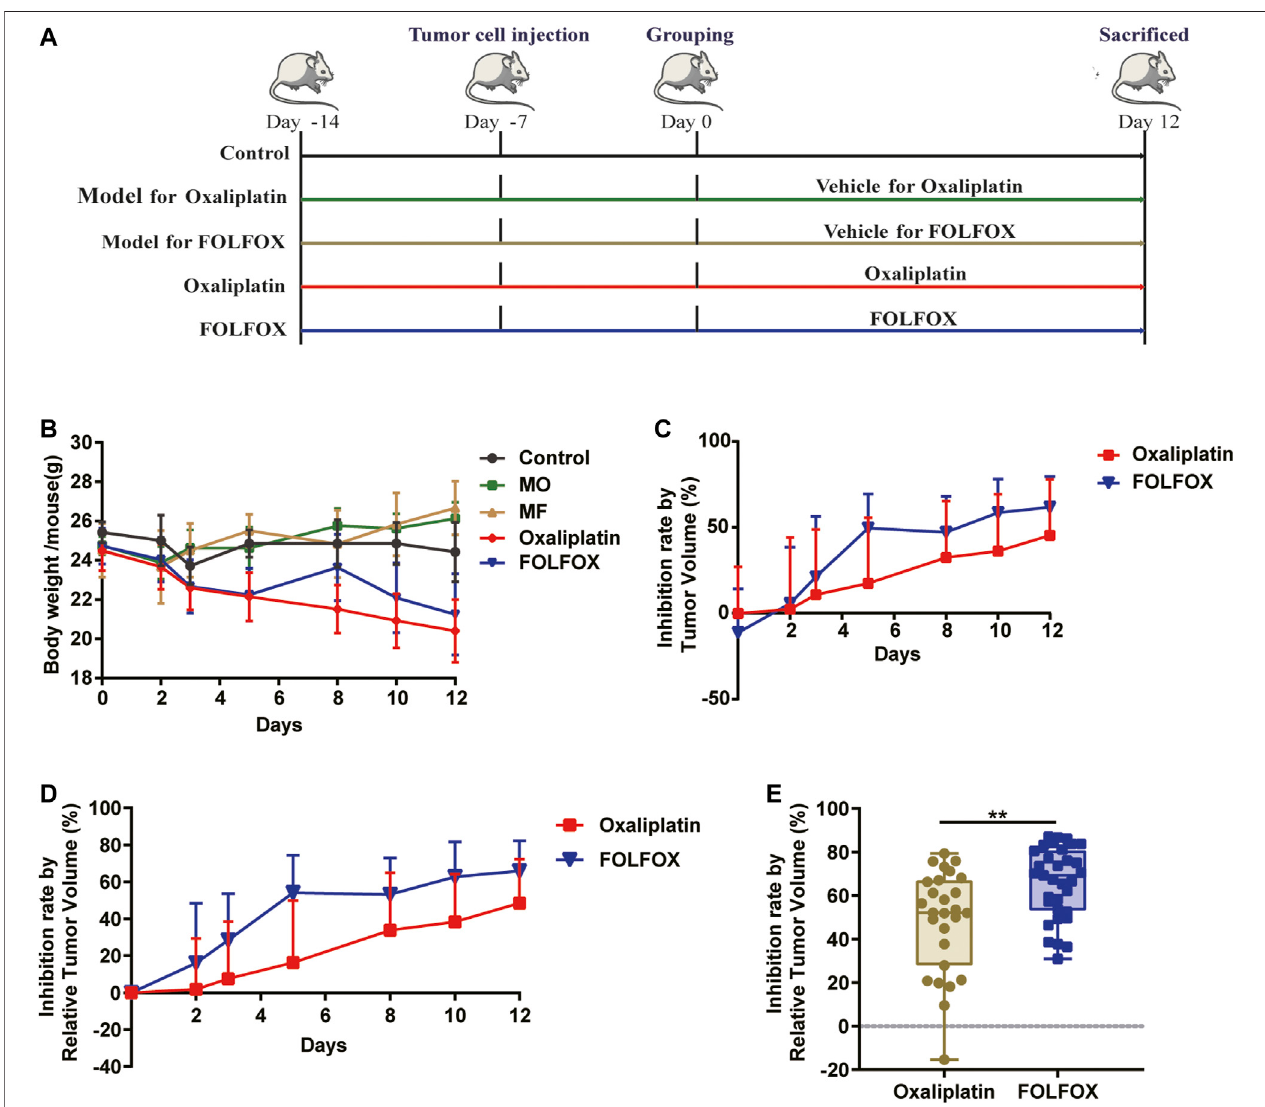
FIGURE 1 | FOLFOX exhibited better chemotherapeutic ef fi cacy in colon cancer xenograft model than oxaliplatin alone. (A) Schematic of the pharmacodynamic evaluation of oxaliplatin and FOLFOX in CT-26 colon cancer xenograft model. (B) In fl uence of oxaliplatin and FOLFOX on the body weight of tumor bearing mice. Inhibitionratewascalculated by (C) TVand (D) RTV. (E) Inhibitionratecalculated byRTVat theend oftheexperiment (day 12). Datawerepresented asmean ± SD. The p -values < 0.05 were considered statistically signi fi cant, * p < 0.05, ** p < 0.01.